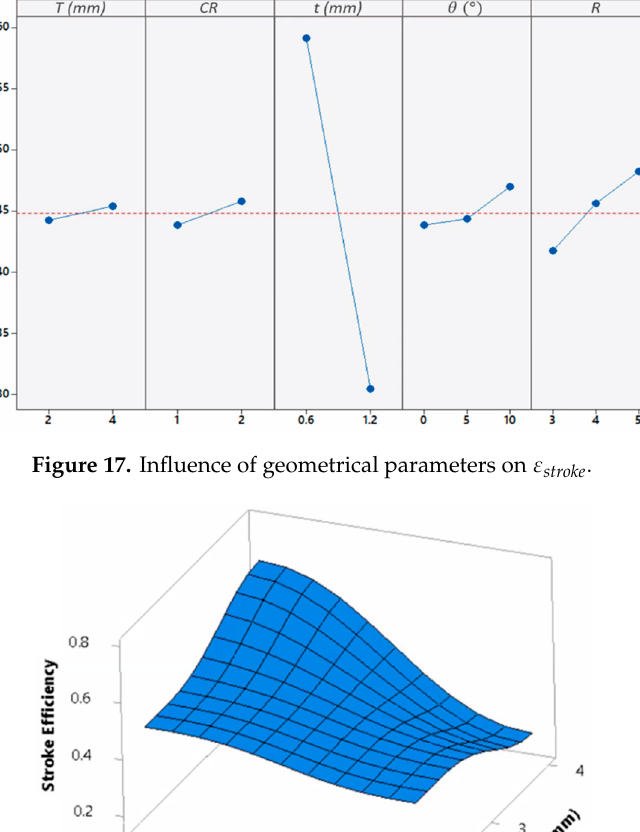
Figure 19. Influence of geometrical parameters on Energy Absorption.